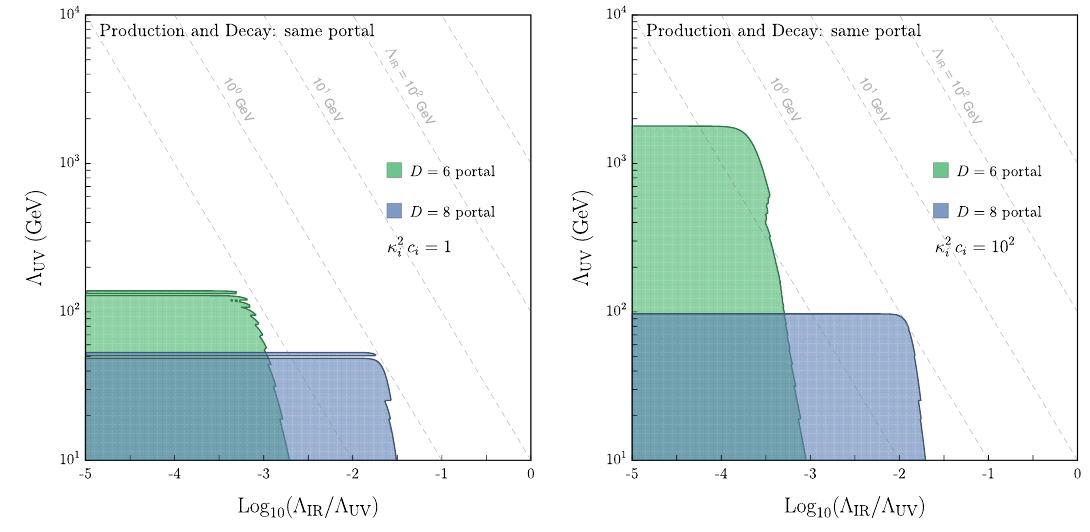
Figure 8 . Constraints on non-resonant DS production from mono-photon searches at LEP. Two choices of portals are shown: J DS ¯ eγ µ e ( D = 6 ) and T DS ( F µ F αν + ¯ eγ µ D ν e ) ( D = 8 ). It is assumed µ µν α that the same portal is responsible for both the DS production and the LDSP decay, and that the dark sector is strongly coupled. The value of κ 2 c i is fixed to 1 in the plot on the left and to 10 2 in i the plot on the